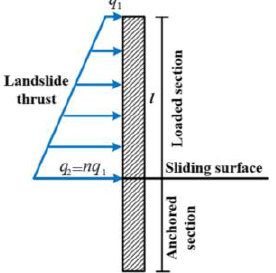
Figure 3. Distribution of trapezoidal thrust load behind an anti-slide pile.